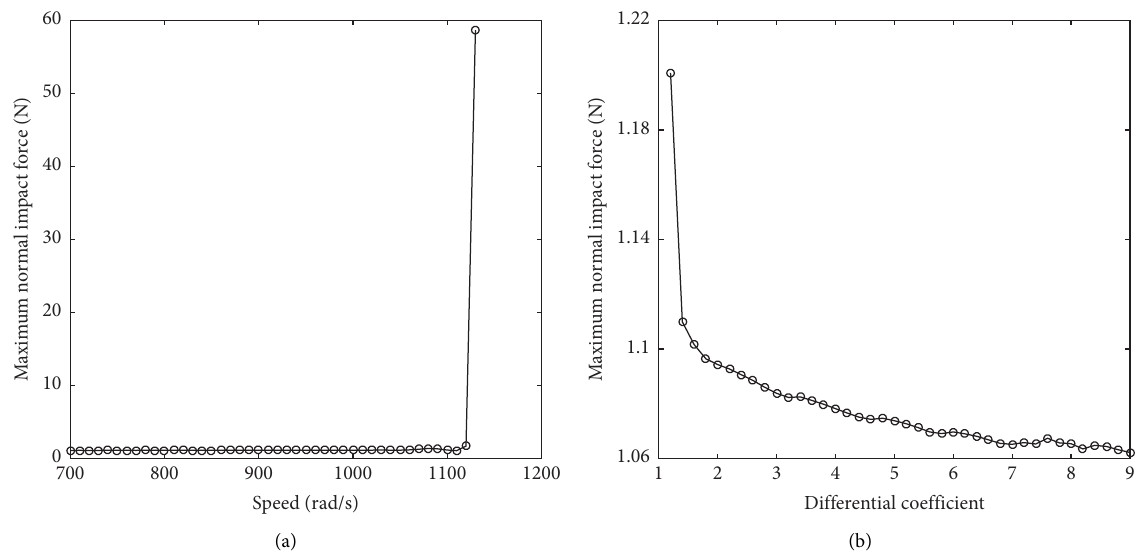
Figure 24: Maximum normal impact forces of the MSDS with K